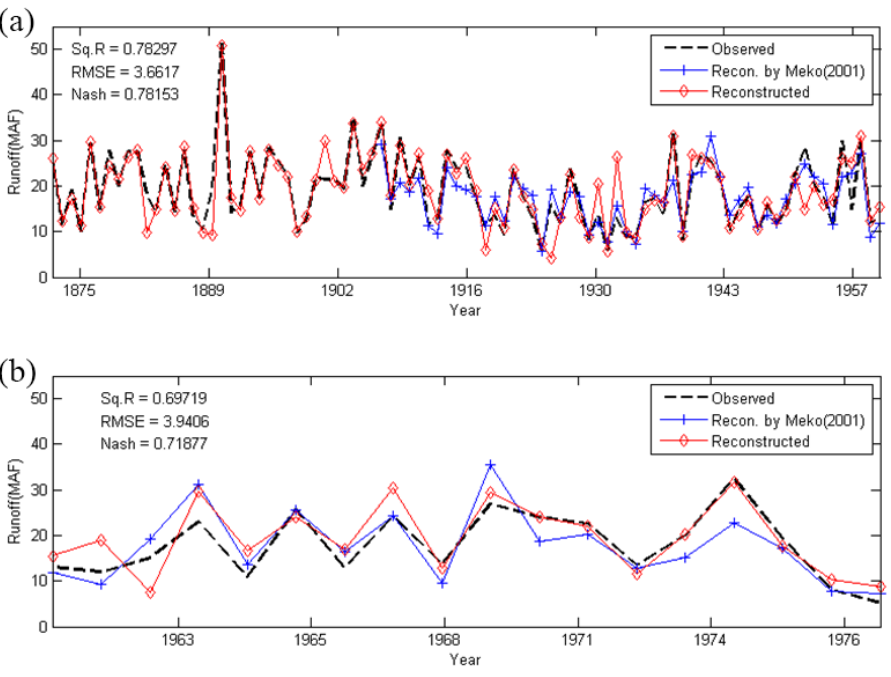
Figure 6. Calibration and validation results with tree ring: ( a ) calibration period (1872 to 1957); and ( b ) validation period (1958 to 1977).